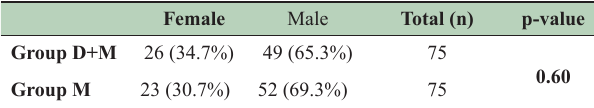
Table-I: Association among the gender and groups.